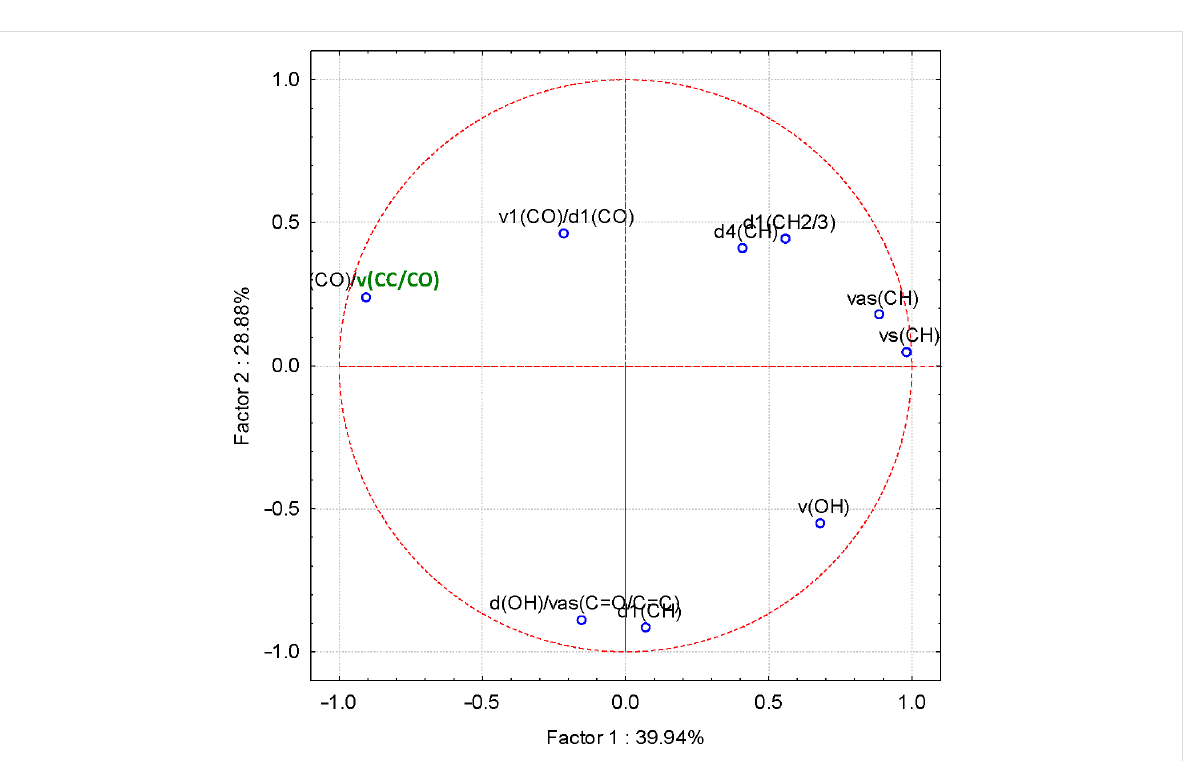
Figure 10: PC 2 versus PC 1 loadings plot from the FTIR–PCA analysis of the β -CD/hazelnut oil/flavonoid ternary complexes and flavonoids; only wavenumbers of the FTIR bands were used as input variables (see Table S12 in Supporting Information File 1 for